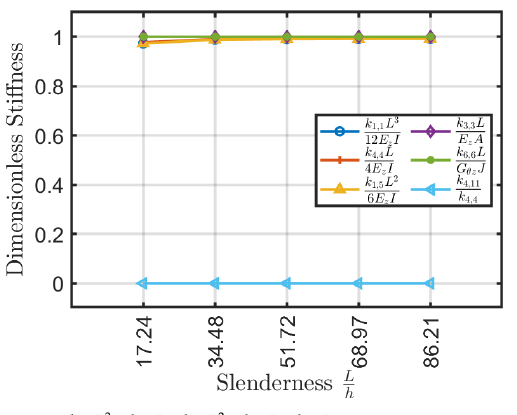
3 2 , k 4,4 L , k 1,5 L , k 3,3 L , k 6,6 L and k 4,11 / k 4,4 as a function of slenderness E z A G θ z J 6 E z I 12 E z I 4 E z I